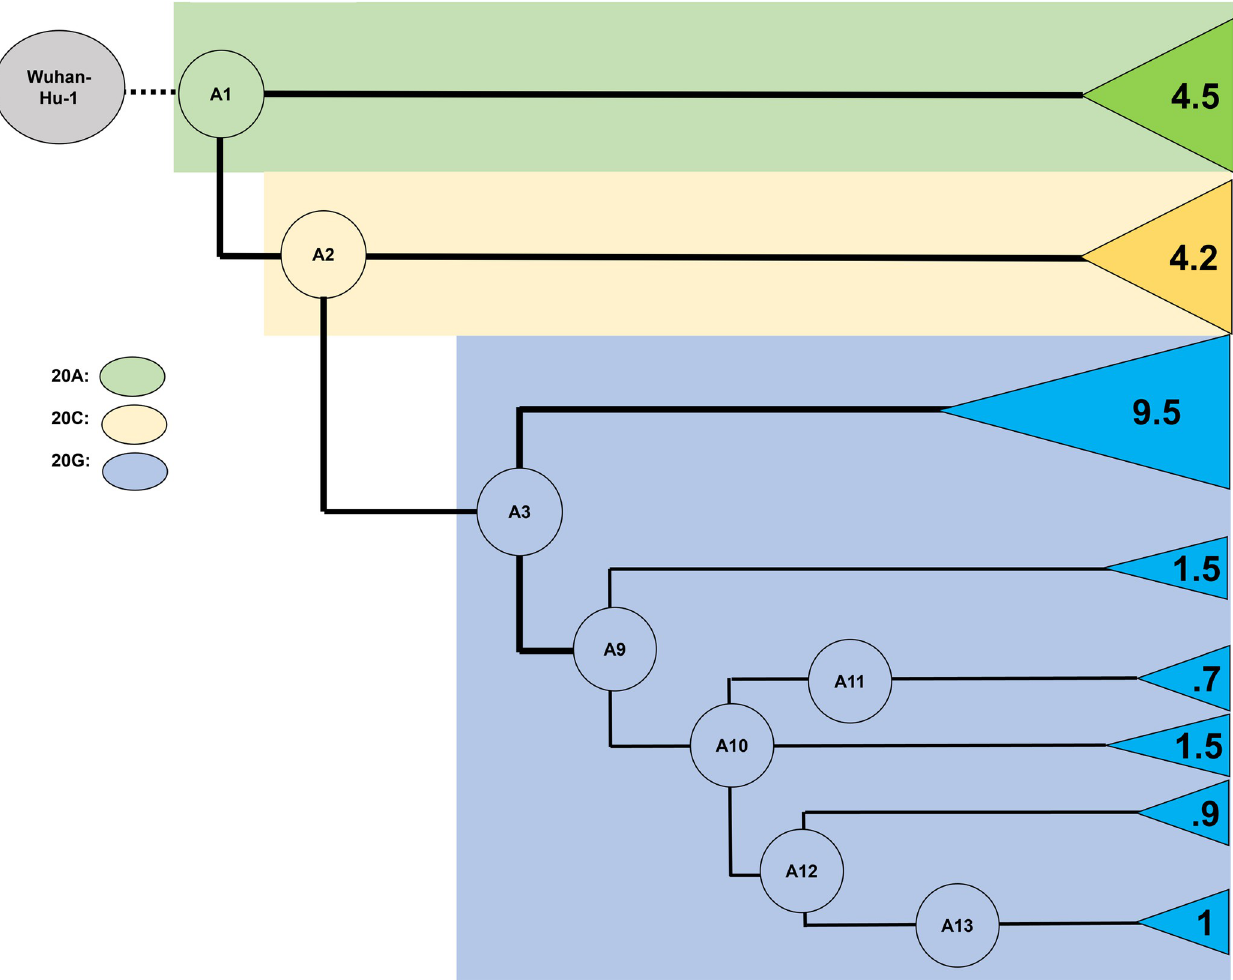
Fig 3. Closely related subset of Air Force samples suggests a novel, rapidly transmitting strain with low average mutation rate, the “Colorado Springs Variant” (A12-A13). Numbers at tips indicate average number of mutations per genome in each ancestral grouping.